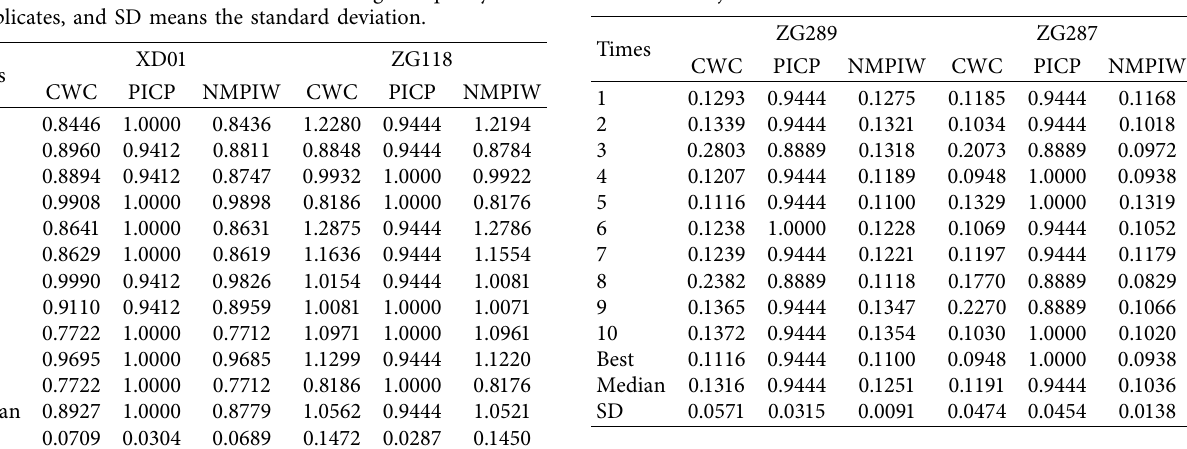
Table 2: Prediction results of the proposed method in the testing set of the Tanjiahe